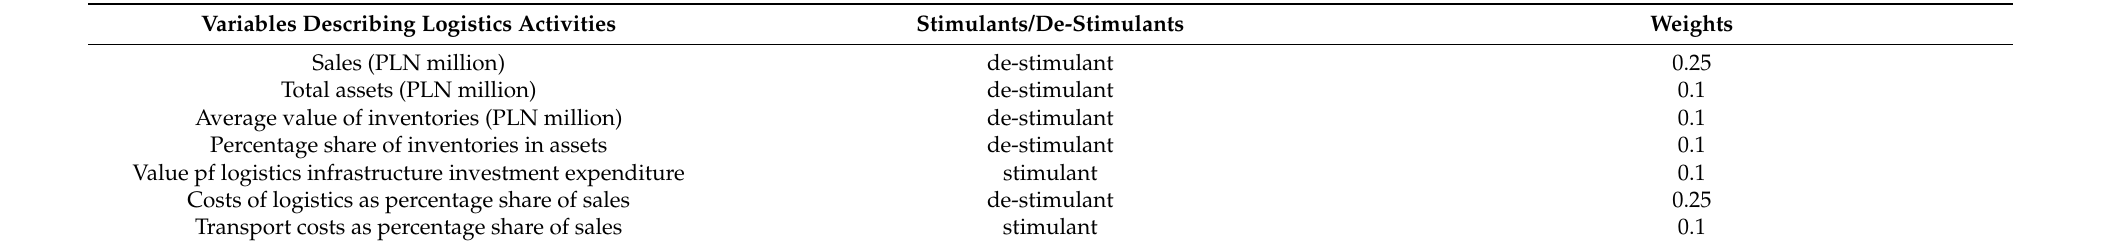
Table 5. Indicators of logistics activities, de-stimulants and stimulants and assigned